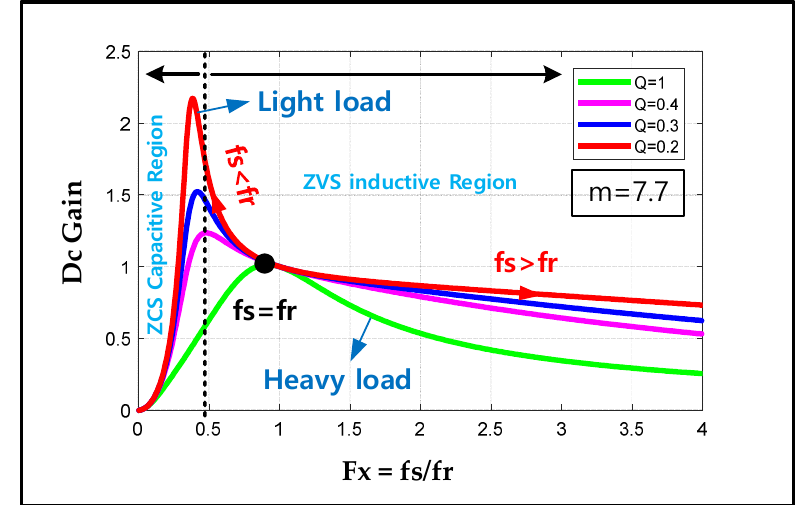
Figure 3. The resonant tank voltage gain curve.